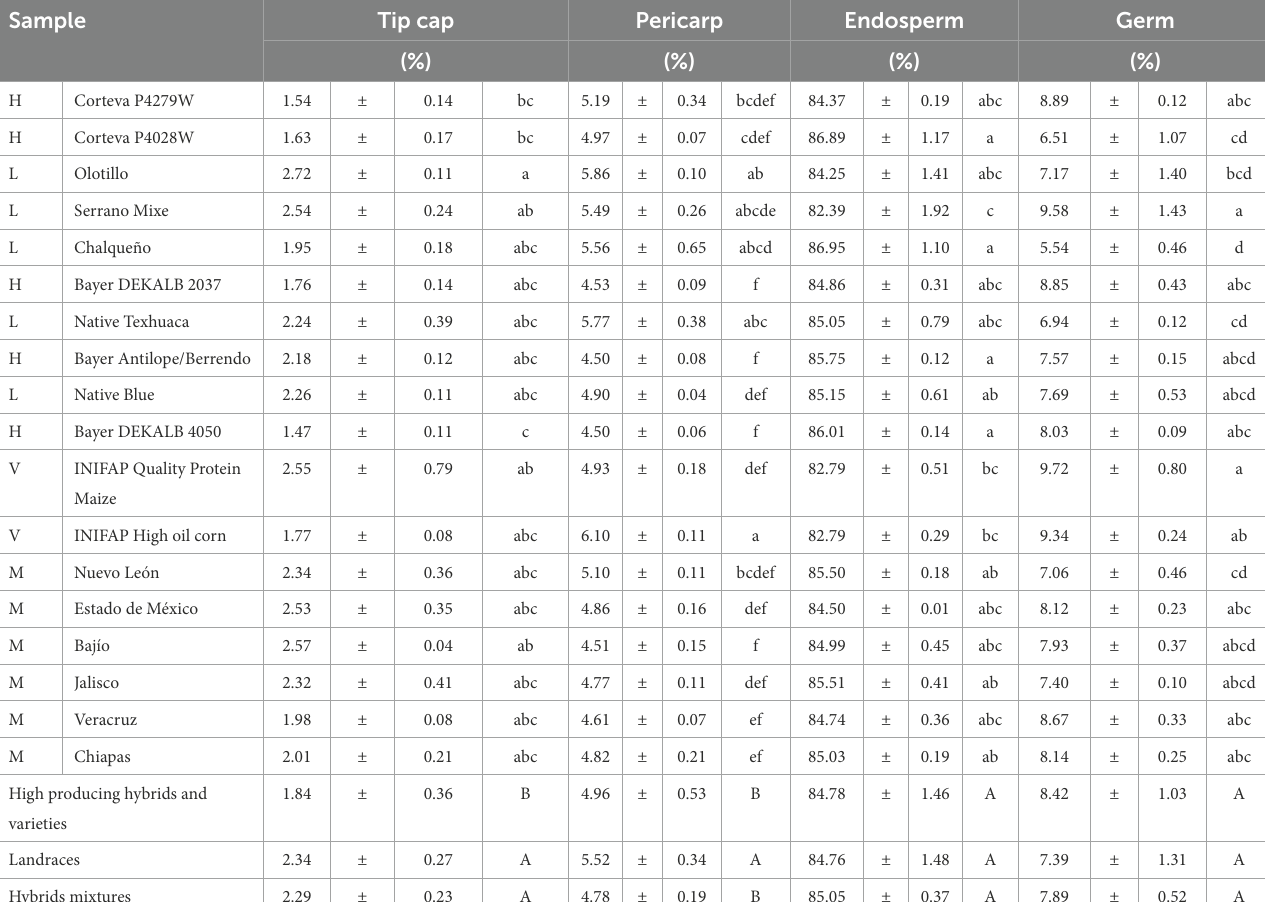
TABLE 3 Anatomical parts of landraces, commercial maize and mixtures of hybrid maize varieties.